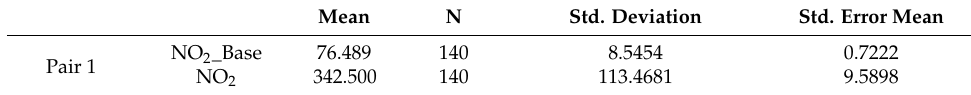
Table 2. Paired Samples Statistics.